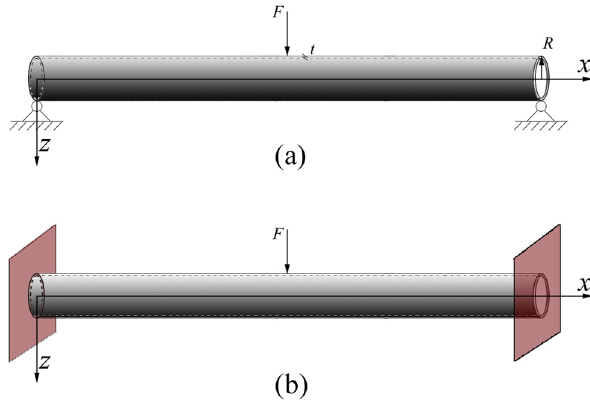
Figure 1: Schematic diagram of bending de fl ection for hollow single - walled BNNTs with simply supported ( a ) and clamped ( b ) con - straints under transverse load.